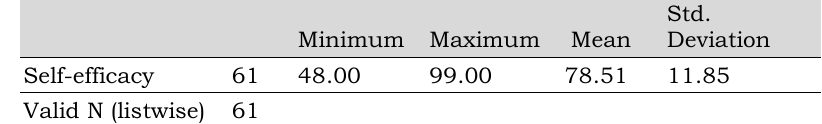
Table 1. Descriptive analysis of self-efficacy